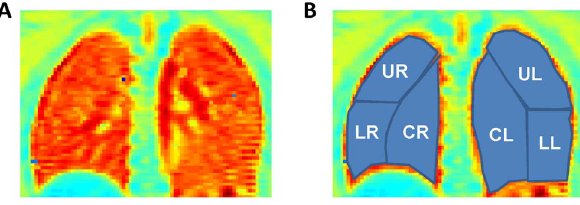
Figure 1. Manual ROI Selection. (a) A representative absolute T1 relaxation time map from a healthy volunteer. (b) The same image with manual ROI’s overlaid. (UR=upper right lung region, UL=upper left lung region, CR=central right lung region, CL=central left lung region, LR=lower right lung region, LL=lower left lung region).